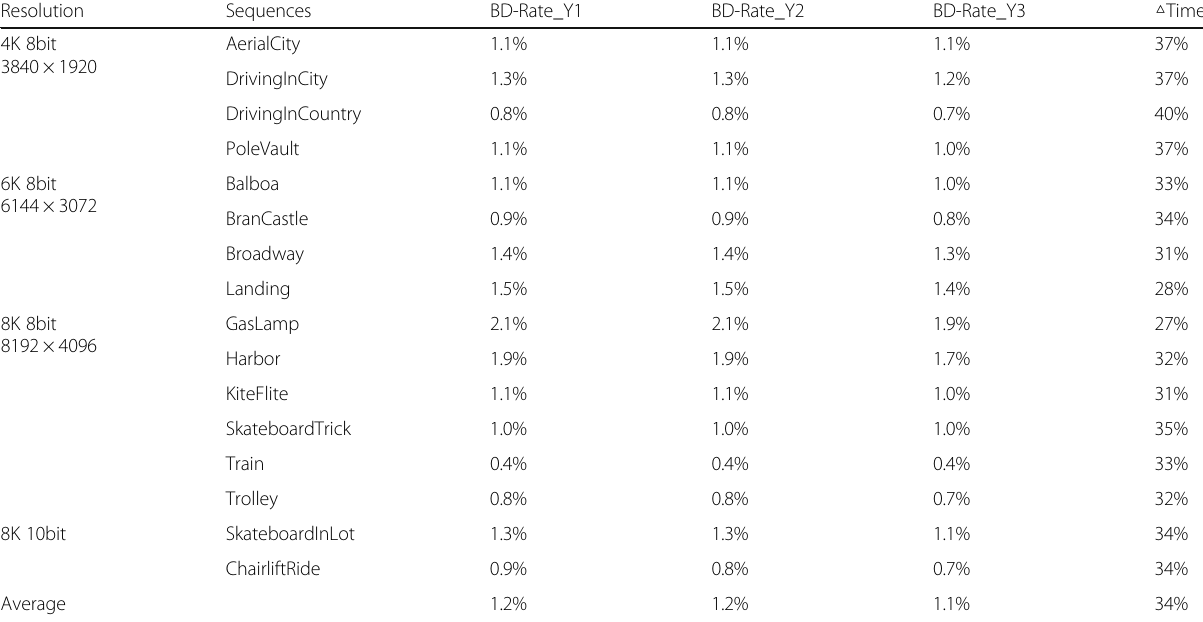
Table 6 Performance comparison between the original HM 16.16 and the proposed mode algorithm